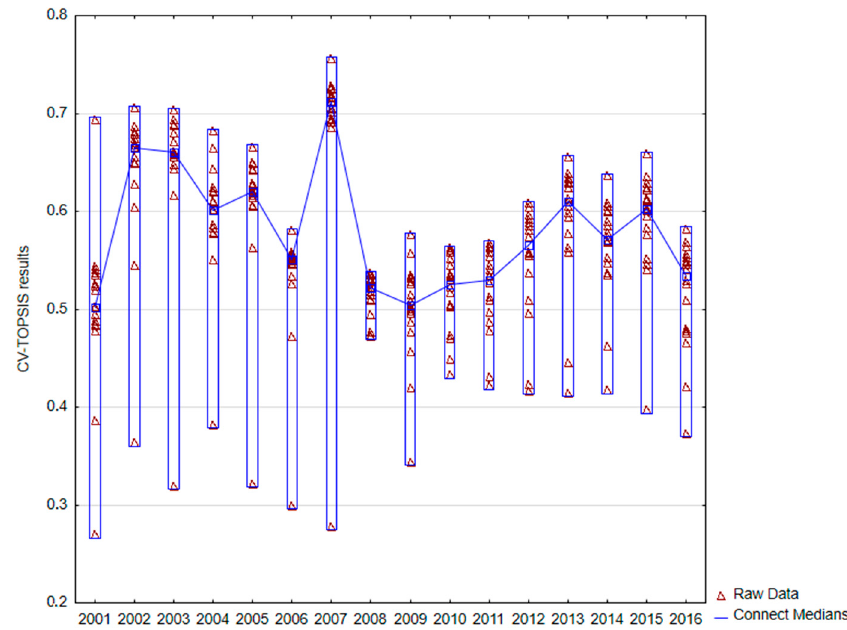
Figure 2. Total results of CV-TOPSIS method for period of years 2001–2016 (variant I.). Conformance of medians wasn´t confirmed (W = 166,895, p ≤ 0.01), which was indicated in a